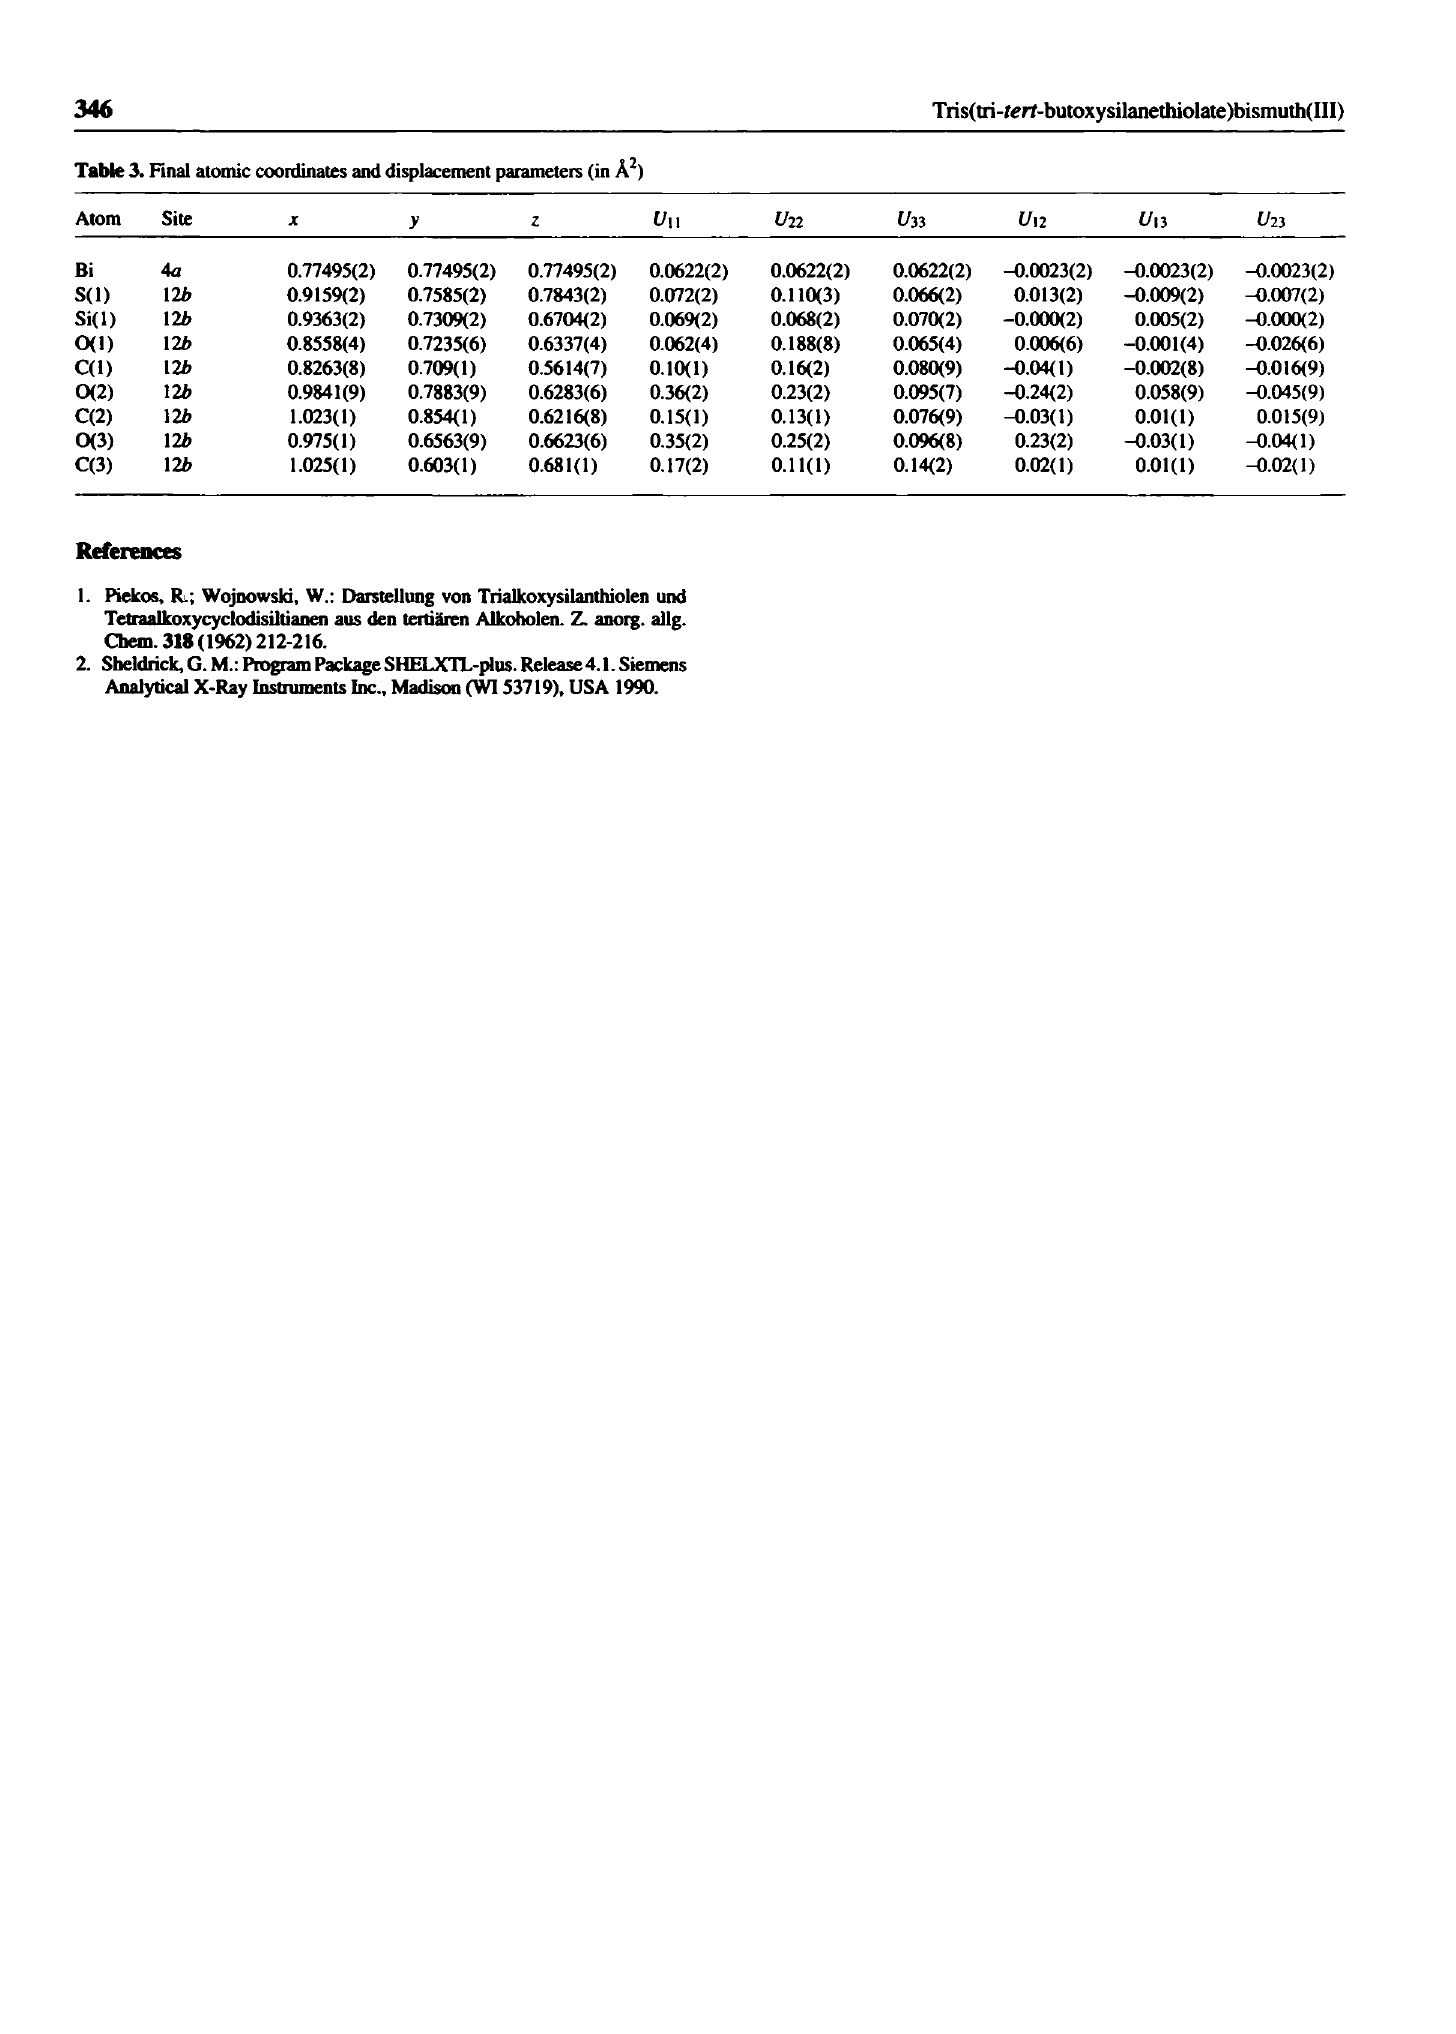
Table 3. Final atomic coordinates and displacement parameters (in A 2